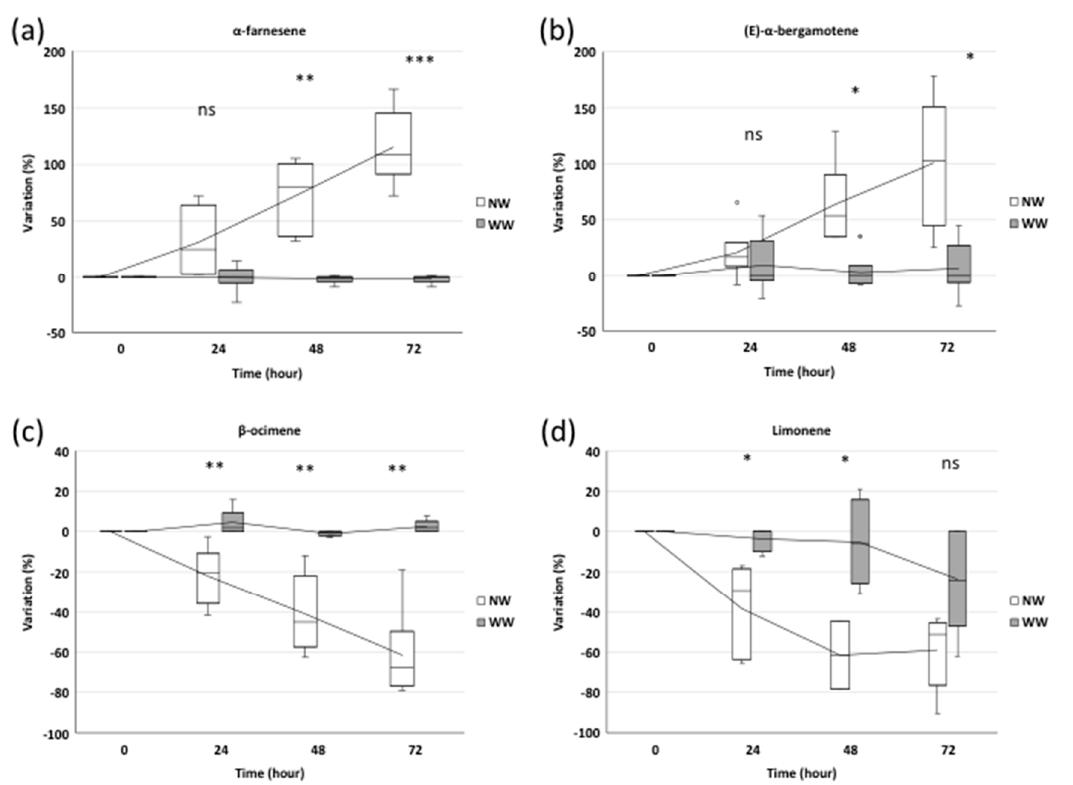
Figure 3. The BVOC profile: Relative amount of the sesquiterpenes α -farnesene ( a ) and (E)- α -bergamotene ( b ) and of the monoterpenes β -ocimene ( c ) and limonene ( d ) evaluated at 0, 24, 48 and 72 h after nematode inoculation in wounded (NW) and without wounding (WW) plants. The box plots refer, for each time point, to three and six independent biological replicates for WW and NW, respectively. A Student’s t-test (df = 7) was applied (*** p ≤ 0.001, ** p ≤ 0.01, * p ≤ 0.05, ns—no statistically significant di ff